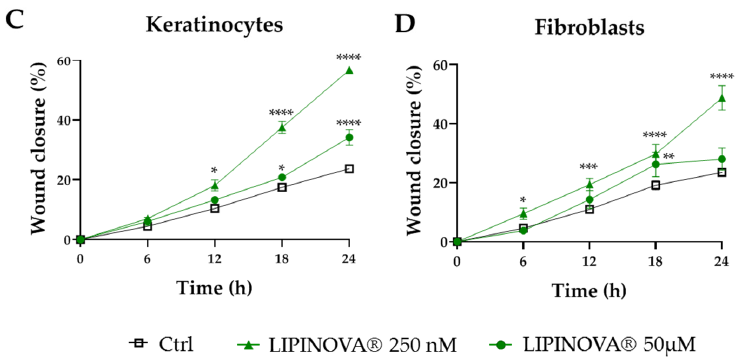
Figure 2. LIPINOVA ® treatment accelerates the in vitro migration of keratinocytes and fibroblasts. Representative brightfield images of a scratch assay at different timepoints after scratching a culture plate of keratinocytes ( A ) and fibroblasts ( B ) treated with 250 nM or 50 µ M of LIPINOVA ® , or with saline (Ctrl). Dotted lines define the wound area; scale bar = 100 µ m. Quantification of wound closure of keratinocytes ( C ) and fibroblasts ( D ) in the presence of LIPINOVA ® . Data were normalized to an initial wound area and are represented as mean ± SD percentage. Images were taken at 20× magnification. Experiments were performed in triplicate. Two-way ANOVA was used for statistical analysis. * p < 0.05, ** p < 0.01, *** p < 0.001, and **** p < 0.0001.